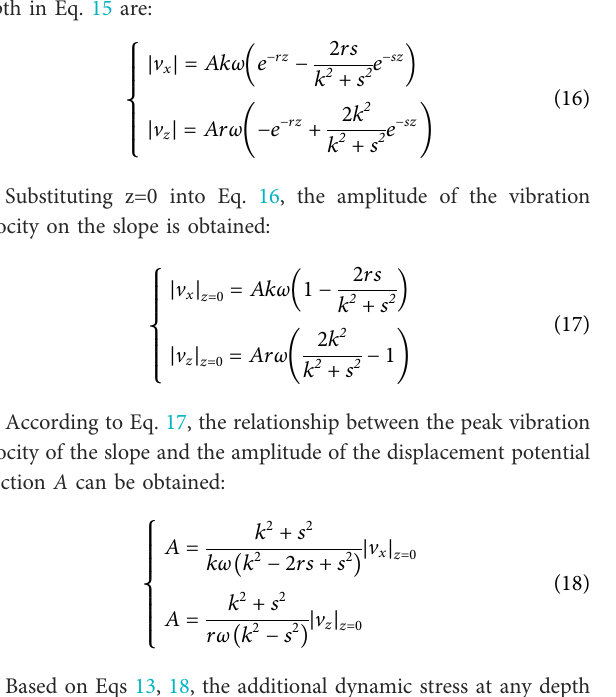
amplitudes of vibration velocities in X direction and Z direction at any